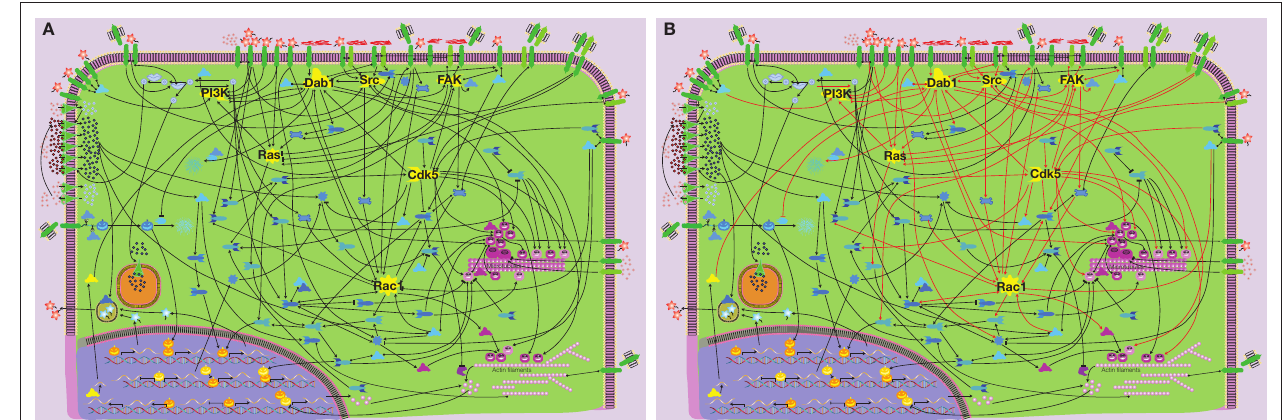
yellow). (B) More than 2/3 of the network connections (shown by red lines) involve hubs. Color code for molecules: yellow – signaling hubs, red – extracellular ligands/matrix components, green – transmembrane receptors/ channels/transporters, etc., blue – intracellular signaling molecules, magenta – microtubule/actin-associated proteins, orange – cell nucleus components.